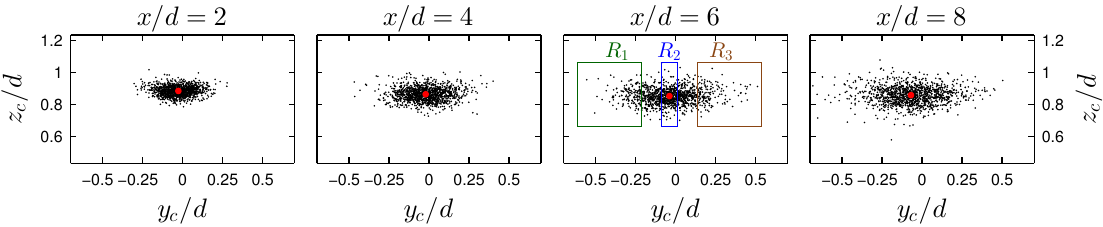
Figure 15. Scatter plot of the instantaneous wake-center position at different downstream locations. The red dots indicate the mean value of the wake-center position at each downstream location. Rectangles R 1 , R 2 and R 3 are used to perform conditional averaging shown in Figure